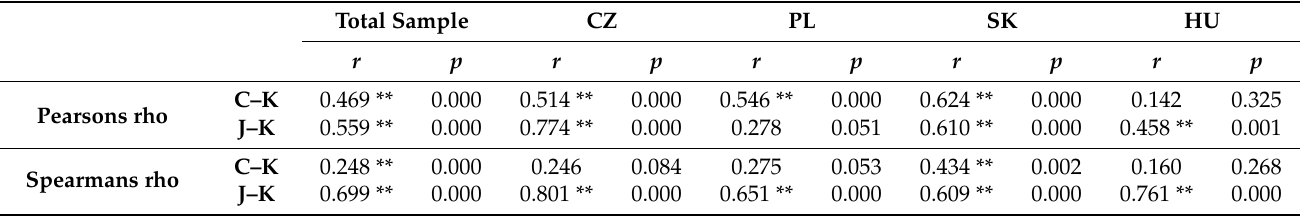
Table 2. Correlations between scholarly output based on SciVal (C) and RPSA (K), and between the number of Scopus publications considered (J) and RPSA